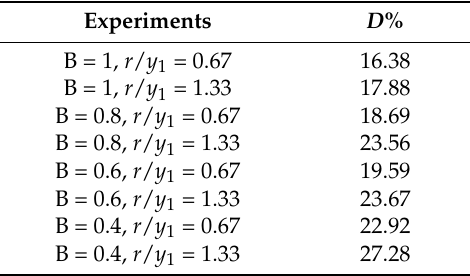
Table 3. Average reduction of the sequent depth ( D